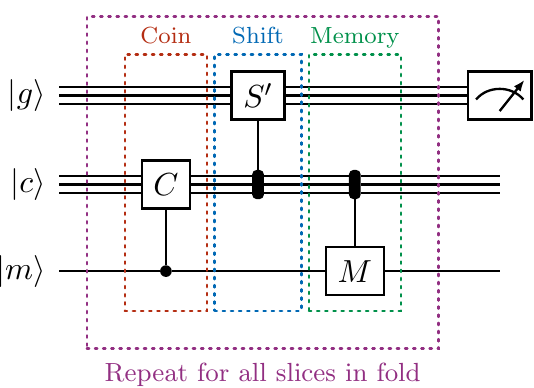
Figure 7. Schematic of the reduced quantum Discrete QCD parton shower algorithm circuit. The